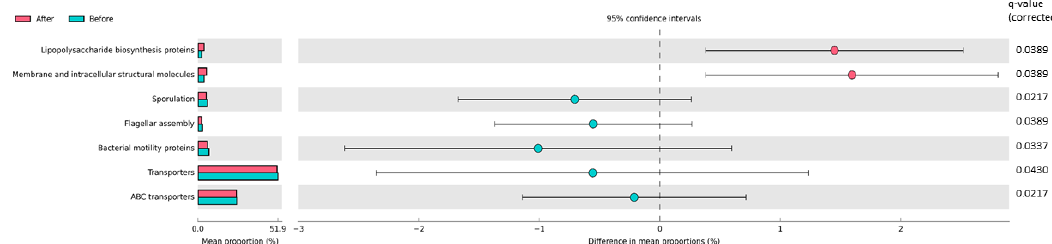
Figure 3. Statistically significant di ff erences in predicted metabolic pathways in obese and overweight patients after the nutritional intervention (NI). The OTUs table generated by QIIME for the bacterial communities was analyzed by using the PICRUSt algorithm. Seven metabolic pathways were significantly di ff erent after NI. Pathways that were more abundant after NI are on the positive side (pink circle with 95% CI). Pathways that were less abundant after NI are on the negative side (light-blue circle with 95% CI). The q-values represent Benjamini–Hochberg’s FDR-corrected p -value (Wilcoxon test for paired data). Mean proportions are shown in stacks (before NI = light-blue; after NI = pink). The di ff erence in mean proportions indicates the mean proportion after NI minus the mean proportion before NI.